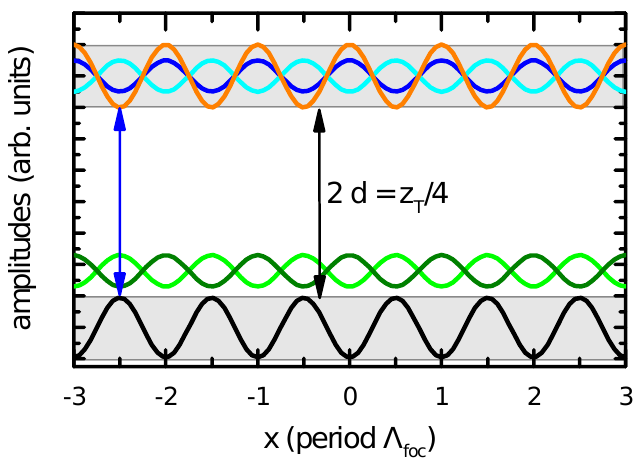
Figure 11. Illustration of feedback loop for single-mirror feedback for quadrupole interactions (see caption of Figure 2 for general explanation). Black line: modulation of imaginary part of coherences v . For red detuning: light (dark) green line: amplitude modulation of transmitted beam for σ − ( σ + ), light (dark) blue: phase of σ − ( σ + ) after a quarter of the Talbot distance, orange line: relative phase between circular polarization components φ L and modulated polarization